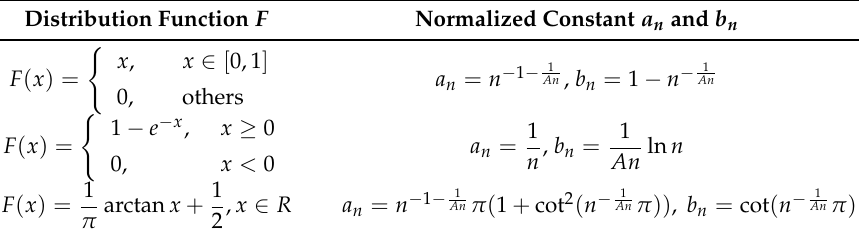
Table 1. Normalized constants a n and b n for the corresponding distributions. Distribution Function